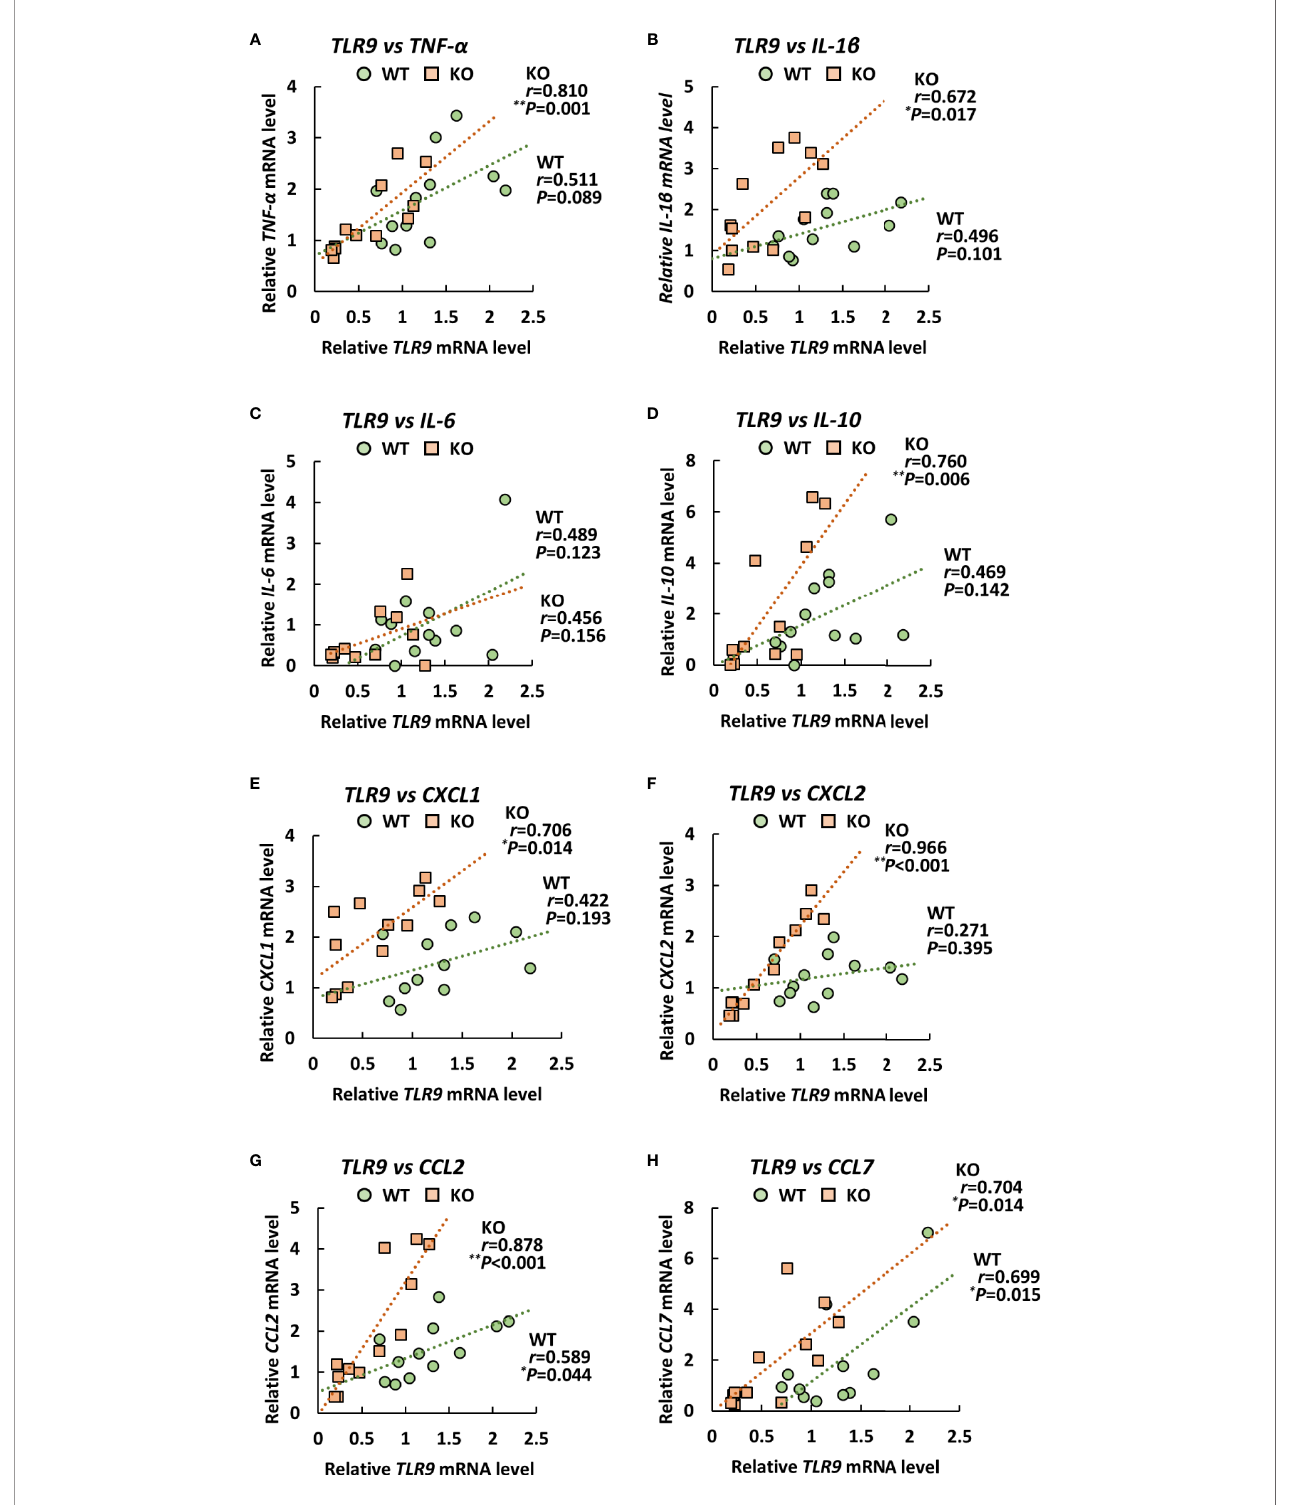
FIGURE 6 | Relationship between the expression of proin fl ammatory cytokines and Toll-like receptor 9 ( TLR9 ) in klotho wildtype (WT) and knockout (KO) mice. Pearson correlation coef fi cient was calculated between the mRNA level of TLR9 and that of (A) TNF- a , (B) IL-1 b , (C) , IL-6 (D) IL-10 , (E) CXCL1 , (F) CXCL2 , (G) CCL2 , (H) CCL7 in klotho WT and KO mice. Each symbol represents one mouse. Asterisks indicate statistically signi fi cant correlations (** P < 0.01; * P <